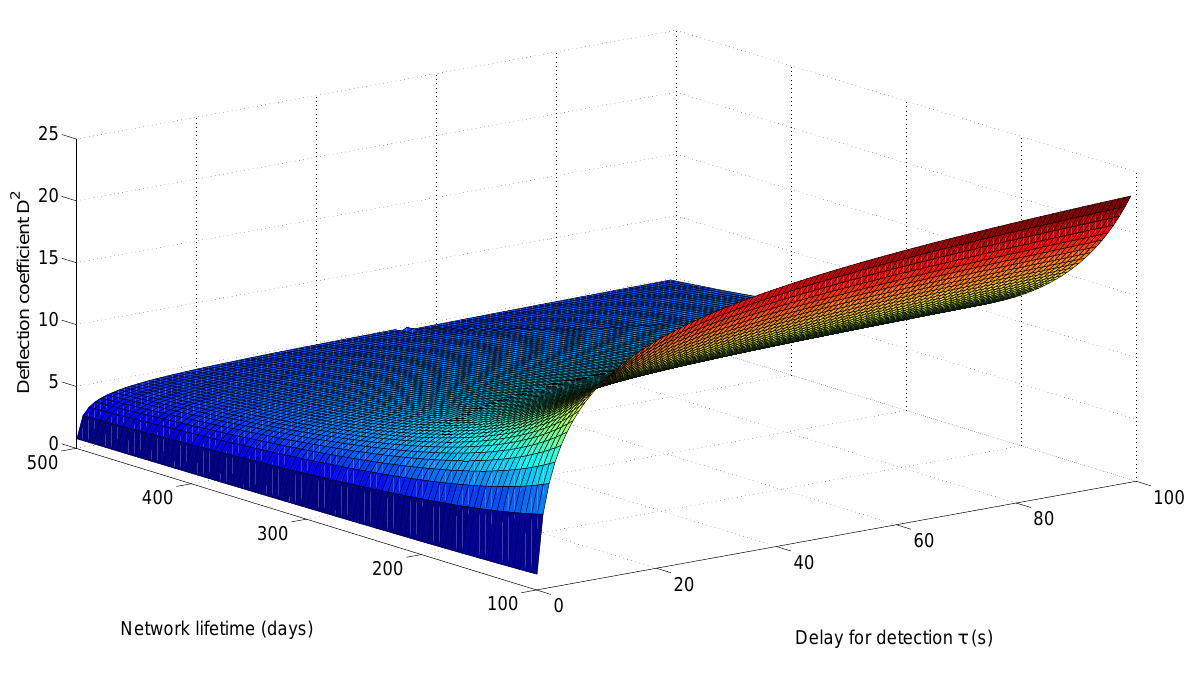
Figure 11. Deflection coefficient as it varies with the network lifetime and delay for detection for the slotted ALOHA with no retransmission (S-ALOHA-NR) tree sensor